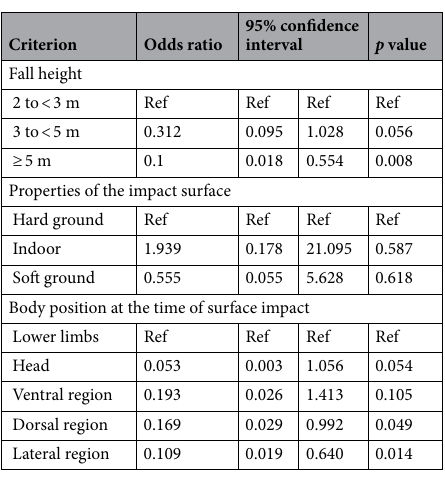
Table 5. Multivariate logistic regression analysis results for the probability of